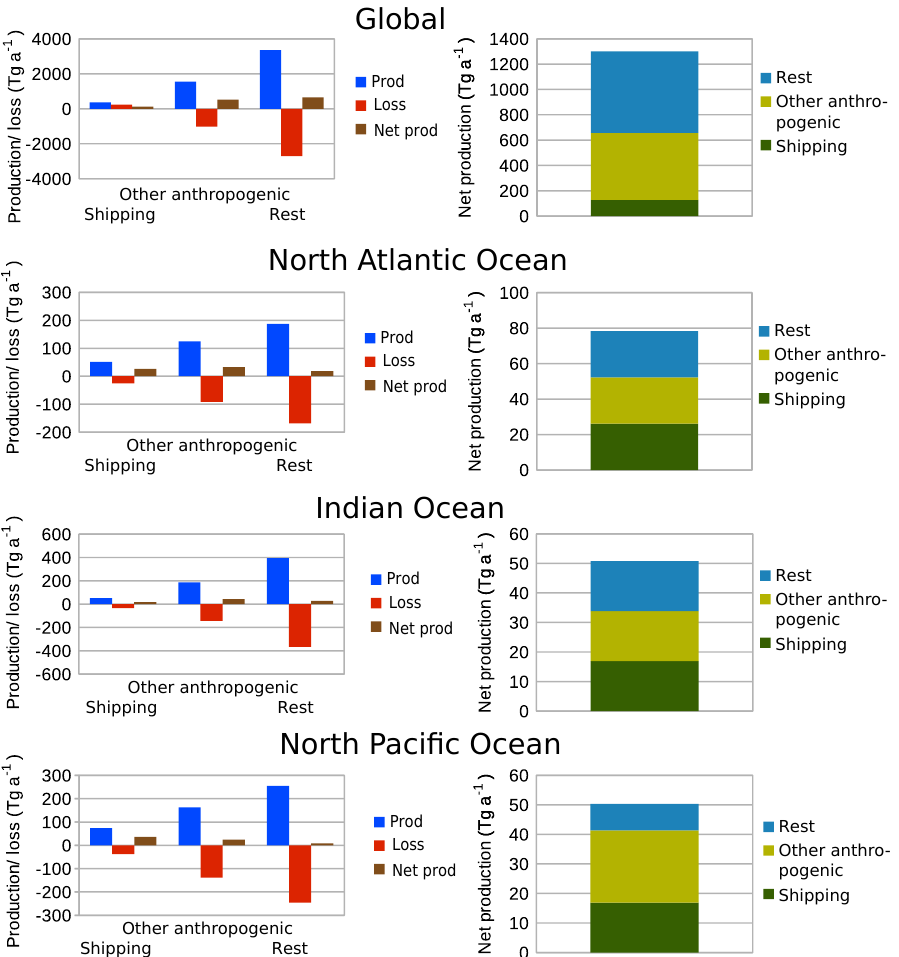
Figure 8. Production and loss rates of O 3 from different sectors (integrated up to 200hPa and averaged for 2006–2010). The left side shows the individual production and loss rates as well as the net O 3 production, while the right side shows only the net production of the different sectors. For simplicity only shipping, other anthropogenic (land transport, anthropogenic non-traffic, and aviation), and the rest (all other tagging categories) are